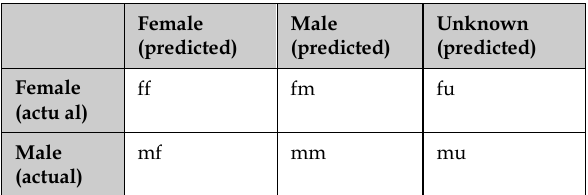
Table 1 Confusion matrix showing six possible classification